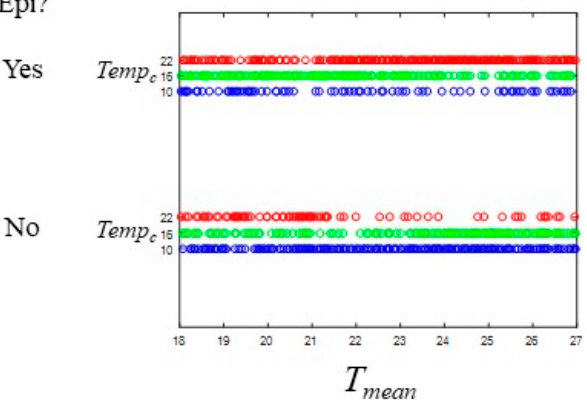
Figure 5. Relationship between epidemic occurrence and mean annual temperature ( T mean ). All three values of Temp c shown (22 °C, red; 16 °C, green; 10 °C, blue). Top set, epidemic occurred; bottom, no epidemic. Each point is one simulation plotted for the T mean from that run set. Other parameters varied in the LHC sampling scheme. Epidemics were more likely at Temp c = 22 °C and with higher values of T mean .